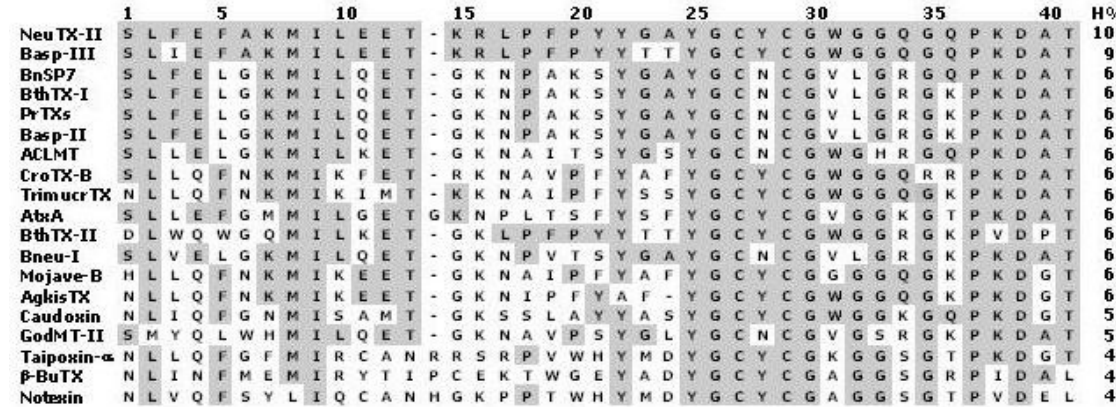
Figure 4. N-terminal amino acid sequence alignment of NeuTX-II with myotoxic and presynaptic toxins. Basp-III, from Bothrops asper venom (23); BnSP7, from B. neuwiedi (46); neurotoxic PLA 2 bothropstoxin-I (BthTX-I), from B. jararacussu venom (8); piratoxins (PrTXs), from B. pirajai venom (48); Basp-II, from Bothrops asper venom (14); ACLMT, a myotoxin from Agkistrodon contortrix laticinctus (22); basic component of crotoxin (CroTX), from Crotalus durissus terrificus (1); trimucrotoxin (TrimucrTX), from Trimeresurus mucrosquamatus (49); ammodytoxin A (AtxA), from Vipera ammodytes ammodytes (42); bothropstoxin-II (BthTX-II), from B. jararacussu (36); Bneu-I, from B. neuwiedi (15); basic component of mojavetoxin (Mojave-B), from Crotalus scutulatus scutulatus (2); agkistrodotoxin (AgkisTX), from Agkistrodon halys pallas (28); caudoxin, from Bitis caudalis (52); from Cerrophidion ( Bothrops ) godmani (11); taipoxin- α , a presynaptic GodMT-II, a myotoxic PLA 2 neurotoxin from Oxyuranus s. scutellatus (31); β -bungarotoxin ( β -buTX), from Bungarus multicinctus (26, 27); notexin, from Notechis scutatus scutatus (17). Conserved residues are in gray. The percentage homology (H%) is also